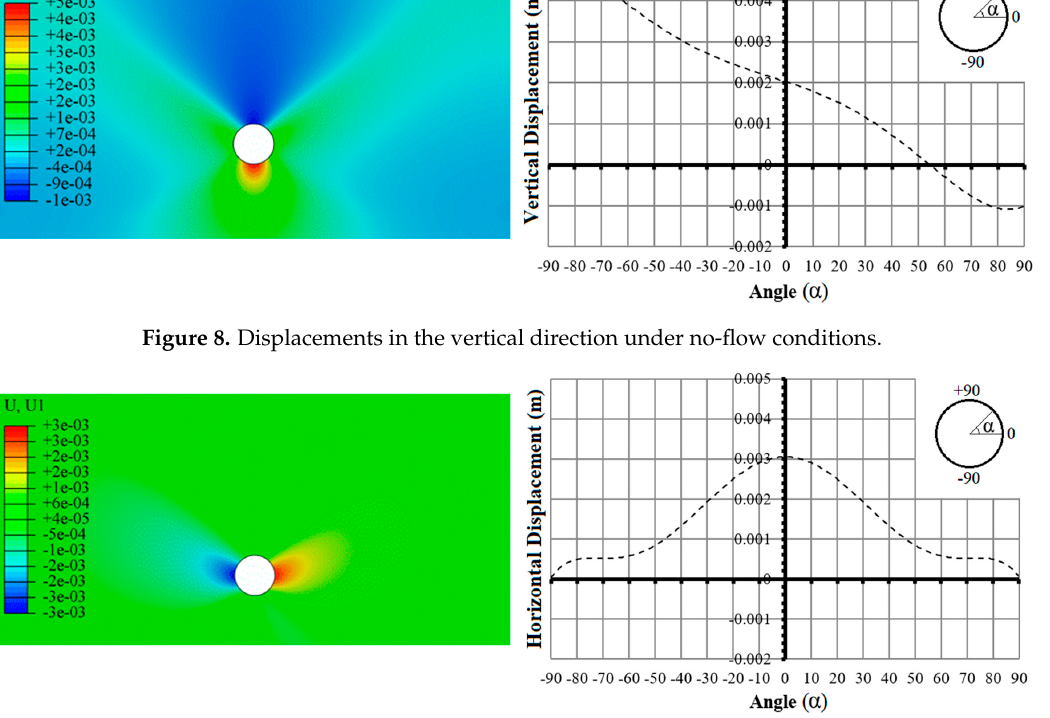
Figure 8. Displacements in the vertical direction under no-flow conditions.